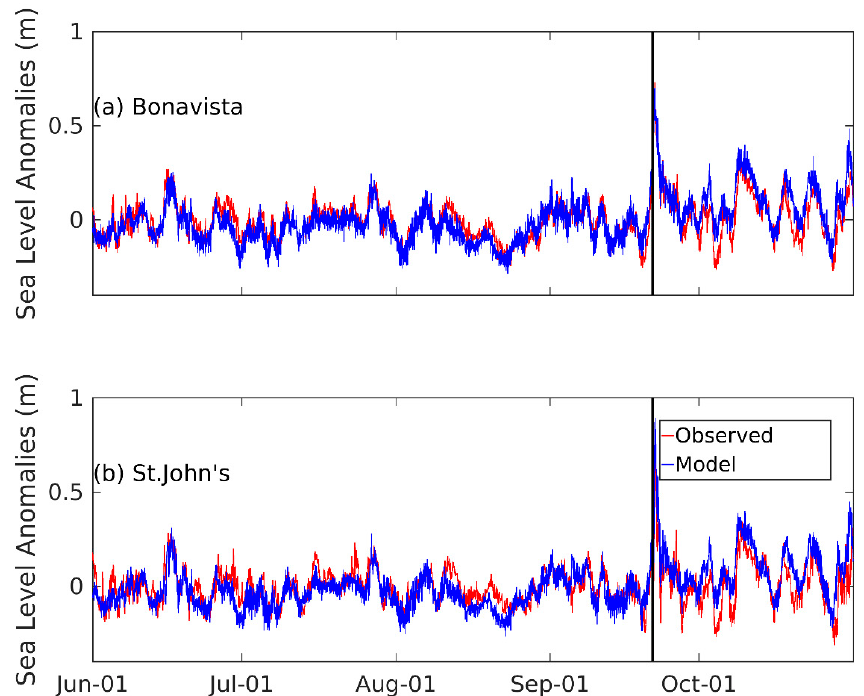
Figure 4. Hourly de-tided sea level anomalies from tide-gauge observations (red) and model results at ( a ) Bonavista and ( b ) St. John’s. The vertical line depicts the landfall time of Hurricane Igor.